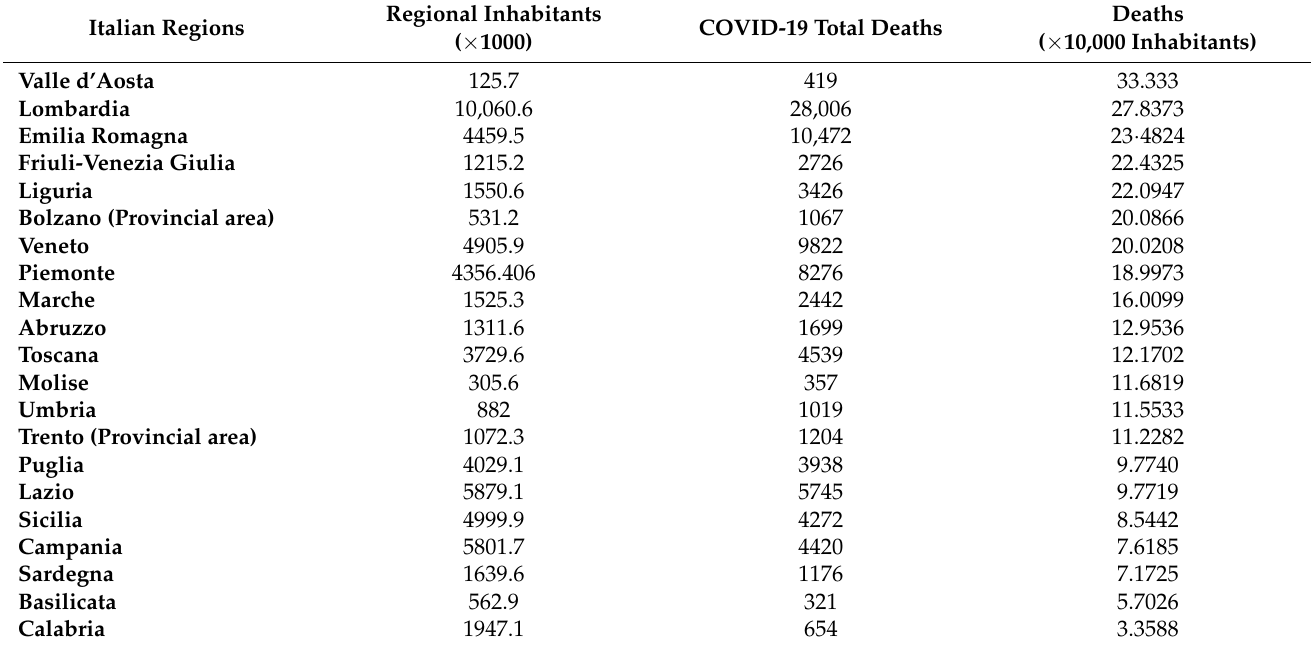
Table 1. The distribution of COVID-19 total deaths, and COVID-19 deaths adjusted for the number of inhabitants in 21 Italian